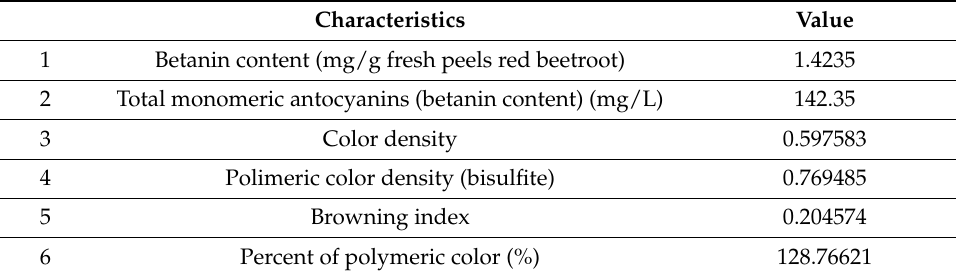
Figure 2. Calibration curve of the extract resulted from peels of red beetroot. Table 1. Characteristics of extract obtained from peels of red beetroot. Table 1. Characteristics of extract obtained from peels of red beetroot.